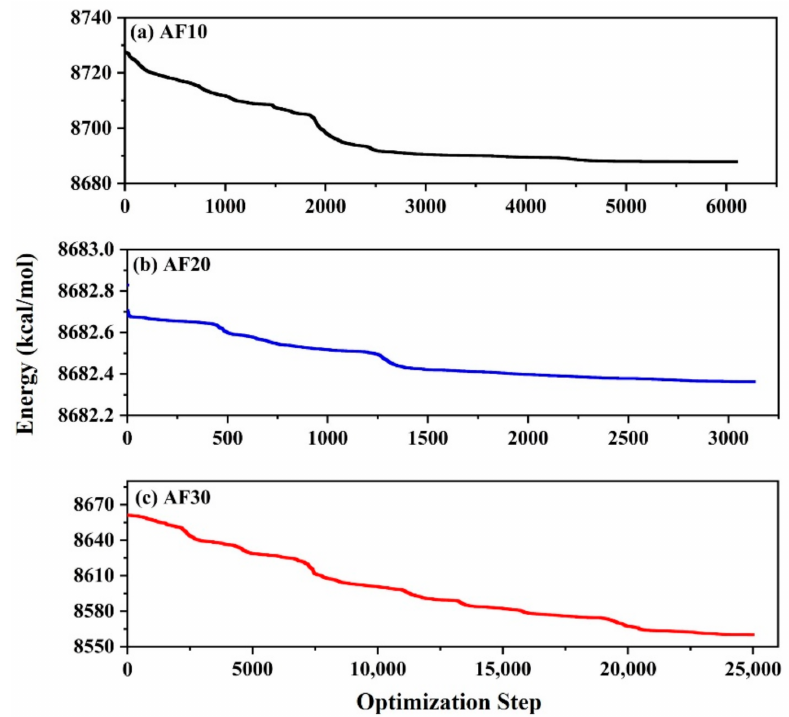
Figure 5. The energy convergence curves of ( a ) AF10, ( b ) AF20, and ( c )